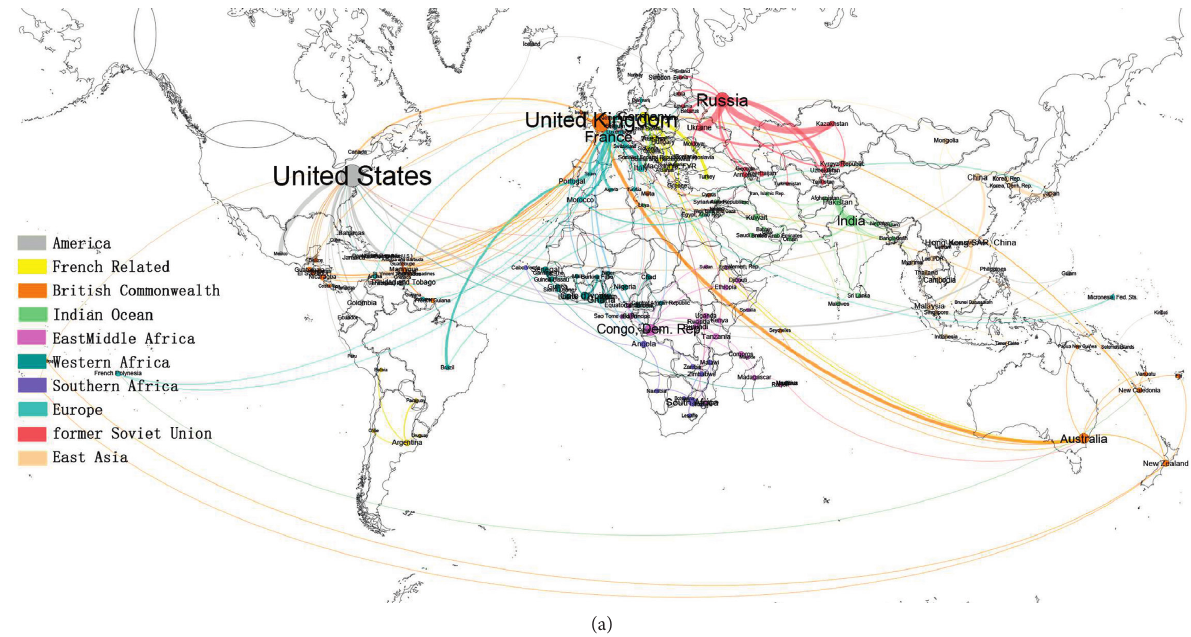
Figure 1: (a) Local inhomogeneity levels during the period of 2010–2015. (b) N The position with a black triangle is the optimized extracting parameter α s that we selected, retaining 3.47% (385) of the edges and 62.22% (5.95 E +7) of the